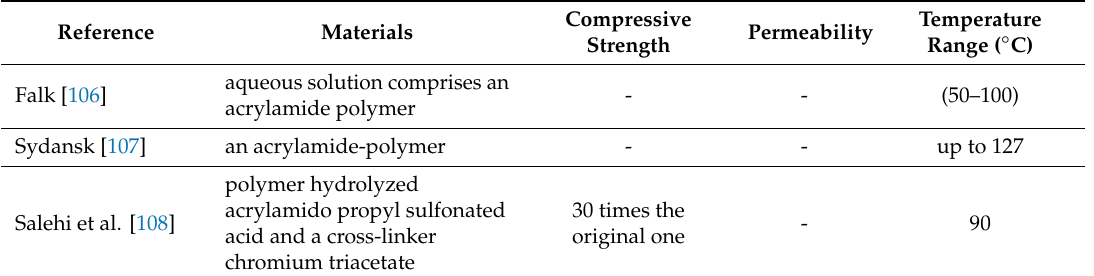
Table 21. Polyacrylamide polymer methods to consolidate sand formation.